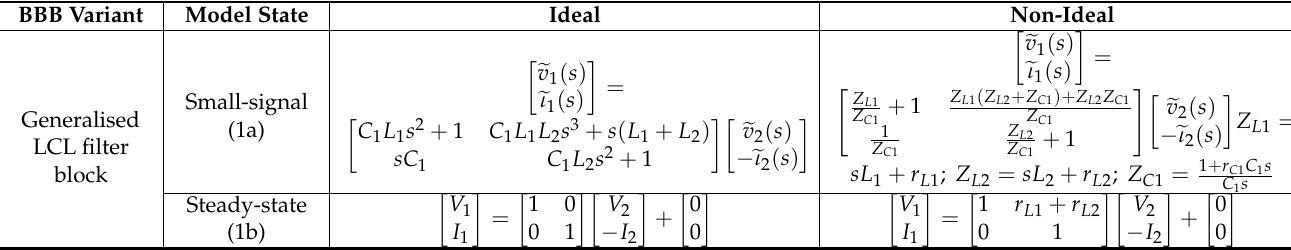
Figure 10. Filter block circuit diagrams. ( a ) Filter components, ( b ) ideal filter components, and ( c ) non − ideal filter components. Table 4. Small-signal and steady-state models for the filter